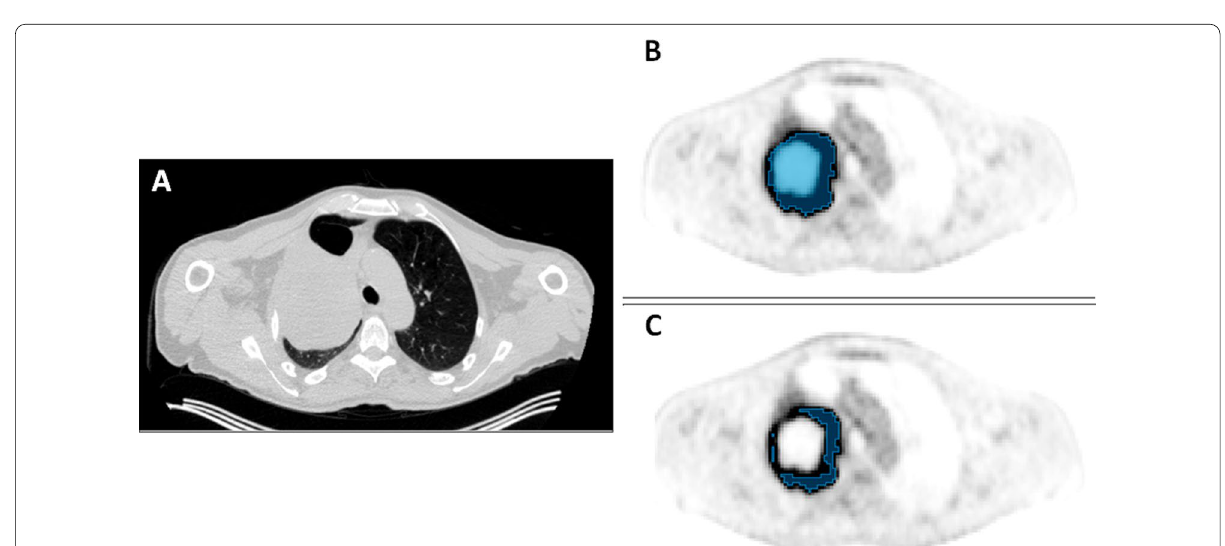
Fig. 5 Example of segmentation of selected regions for biomarker derivation requiring specification in standard operating protocols: Axial [ 18 F] FDG PET/CT images through the mid thorax in a patient with a T3N1M0 non‑small cell lung cancer. On the CT component in ( A ), contrast within the mass is poor. The PET scan ( B , C ) differentiates the tumour with a centrally necrotic area. The entire tumour has been segmented in ( B ), but as inclusion of necrosis impacts quantitative biomarker derivation, exclusion of the central necrosis during segmentation, as shown in ( C ), is preferable. The vital tumour volume was delineated using a threshold of 41% of the SUV peak obtained using a sphere of 12 mm diameter, corrected for local background. The gross tumour volume was generated by adding the volumes of the central necrosis to the vital tumour